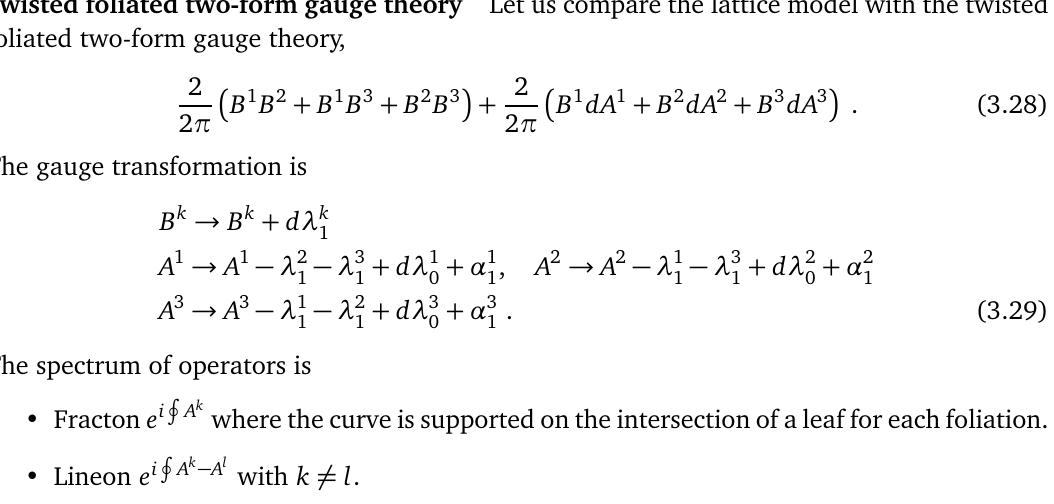
Figure 6: The edge and flux terms for the Hamiltonian model of twisted foliated (cid:90) two-form gauge theory. Each face in a x k − x l plane has two qubits of types x k , x l . We label the top row of excitations as e Y Z , e XZ , e XY , and the bottom row as f 1 , f 2 , f 3 (from left to